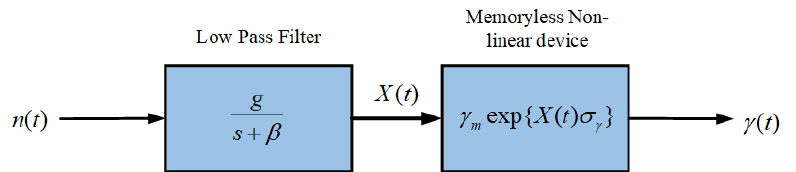
Figure 4. Memoryless non-linear device used in M-K model, where β is the dynamic parameter of the model, which signifies the rate of change of attenuation; g is the gain; X ( t ) is the low-pass filtered output; and γ ( t ) is the attenuation. Algorithm 10: M-K Model